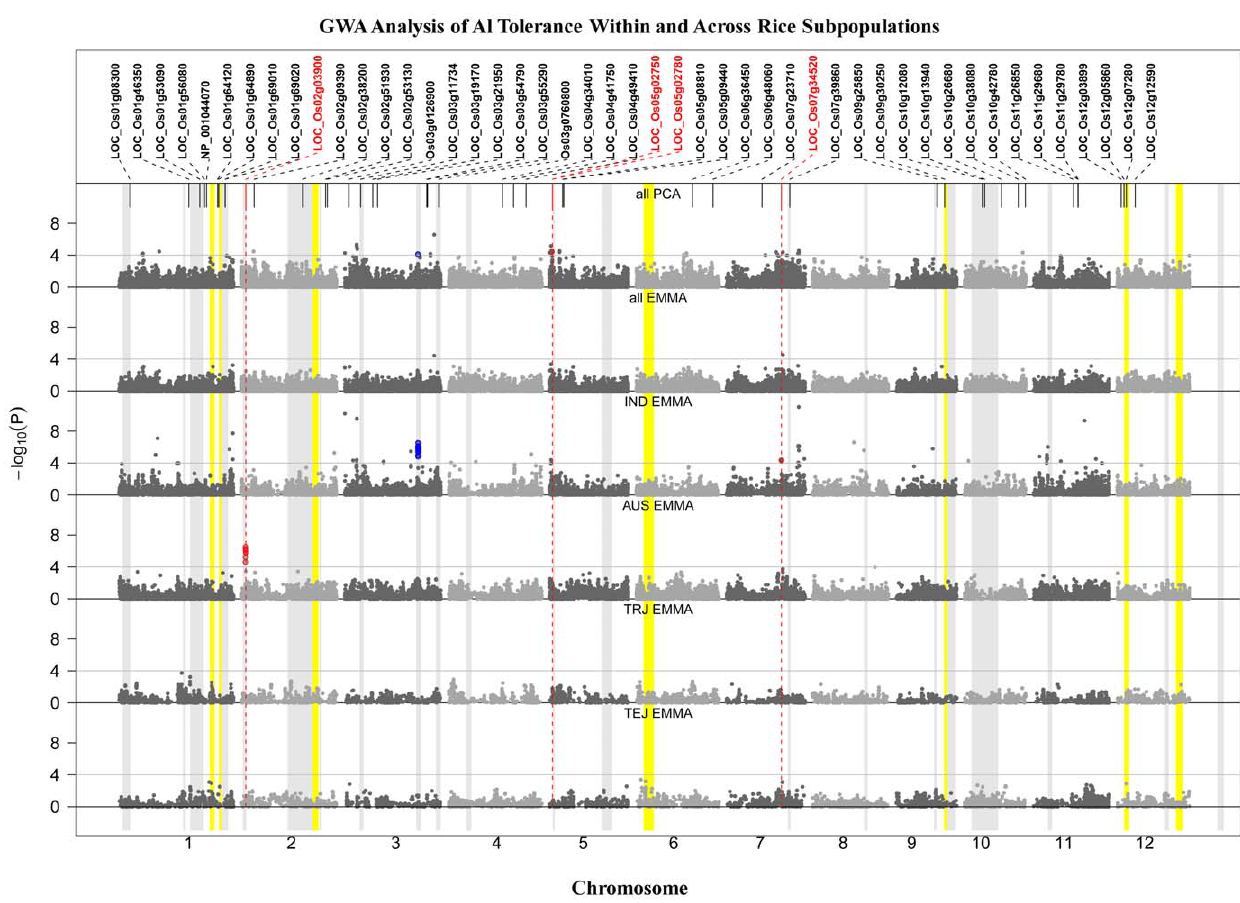
Figure 3. GWA Analysis of Al Tolerance within and across Rice Subpopulations. GWA analysis across and within subpopulations (IND =indica ; AUS =aus ; TRJ= tropical japonica ; TEJ= temperate japonica ). A priori candidate genes are listed across the top, with those identified within 200 kb of significant SNPs colored red. Color bands indicate the 23 bi-parental QTL positions from previous reports (grey) or from this study (yellow). SNP color indicates co-localization with QTLs (blue) or candidate genes (red).